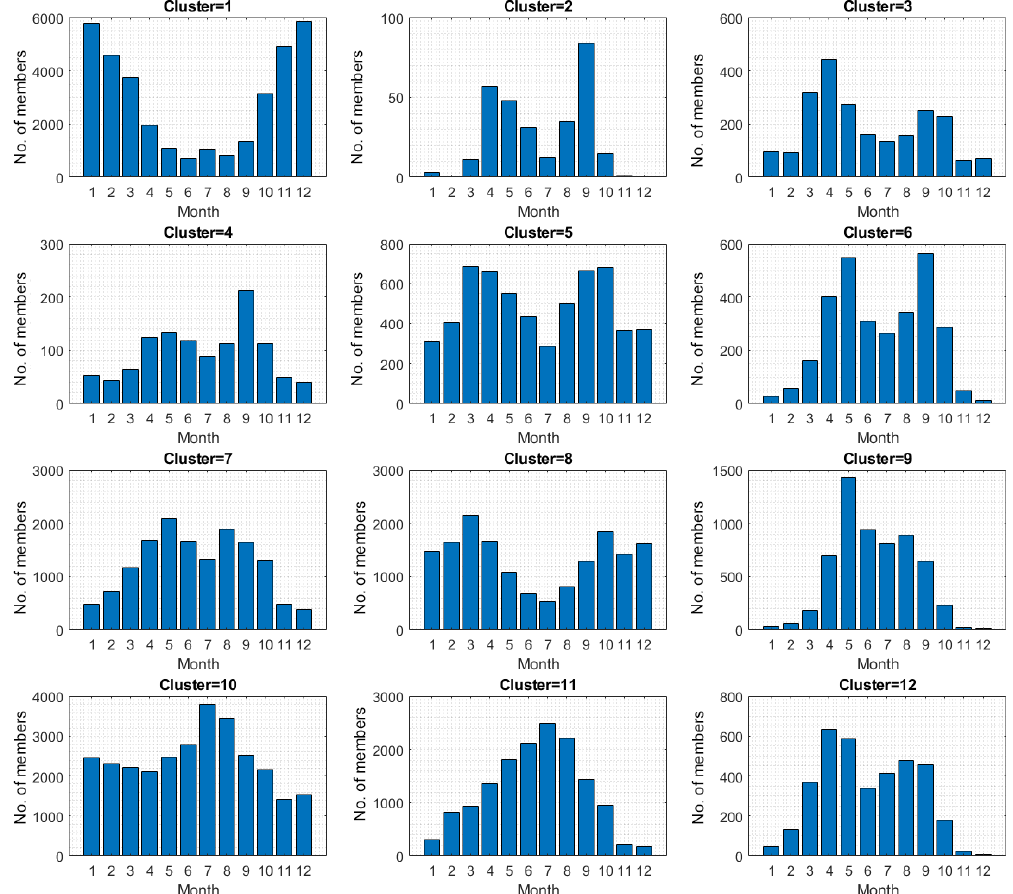
Figure 4. Seasonal distribution of clusters 1–12. Panels indicate the number of cluster members observed for a given month